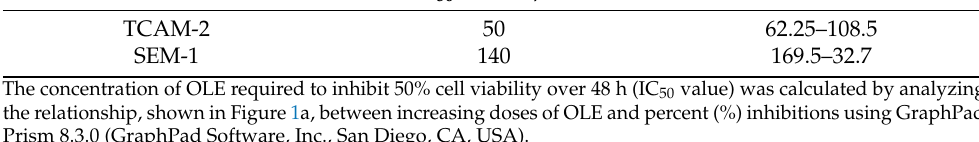
Figure 1. ( a , b ) MTT assay in testicular cancer cells and HepG2 cells. TCAM-2 and SEM-1 cells were treated or not with increasing doses (15–200 µ M) of OLE for 48 h. Cell proliferation is expressed in fold change ± standard deviations (SD) with respect to basal conditions and is representative of three independent experiments, each performed in eight replicates. Statistical significance was considered at * p < 0.05; ** p < 0.001 NS = not significant. Statistical comparisons were drawn between groups using a one-tailed t -test. (-) = control. ( c ) Immunoblotting showing the CD1 protein expression in TCAM-2 and SEM-1 cells exposed for 48 h to OLE (50 µ M TCAM-2; 140 µ M SEM-1). GAPDH was used as a loading control. The histograms represent the mean ± SD of three separate experiments (each performed in triplicate) in which band intensities were evaluated as the optical density and are represented as fold change for treated vs. untreated cells normalized for the loading control. ** p < 0.001, * p < 0.05 treated vs. untreated cells. ( d ) Protein expression of p21 Cip/WAF1 in TCAM-2 and SEM-1 cells exposed for 48 h to OLE (50 µ M TCAM-2; 140 µ M SEM-1). GAPDH was used as a loading control. As in ( c ), the histograms represent the mean ± SD of three separate experiments (each performed in triplicate), in which the band intensities were evaluated as the optical density and are represented as fold change for treated vs. untreated cells normalized for the loading control. The numbers on the peaks reported on the top of each blot represent the size of the corresponding slot as a percentage of the total size of the two slots in each condition. * p < 0.05 treated vs. untreated cells. Table 1. IC 50 value of OLE in TCAM-2 and SEM-1 cells derived from the MTT assay. Cell